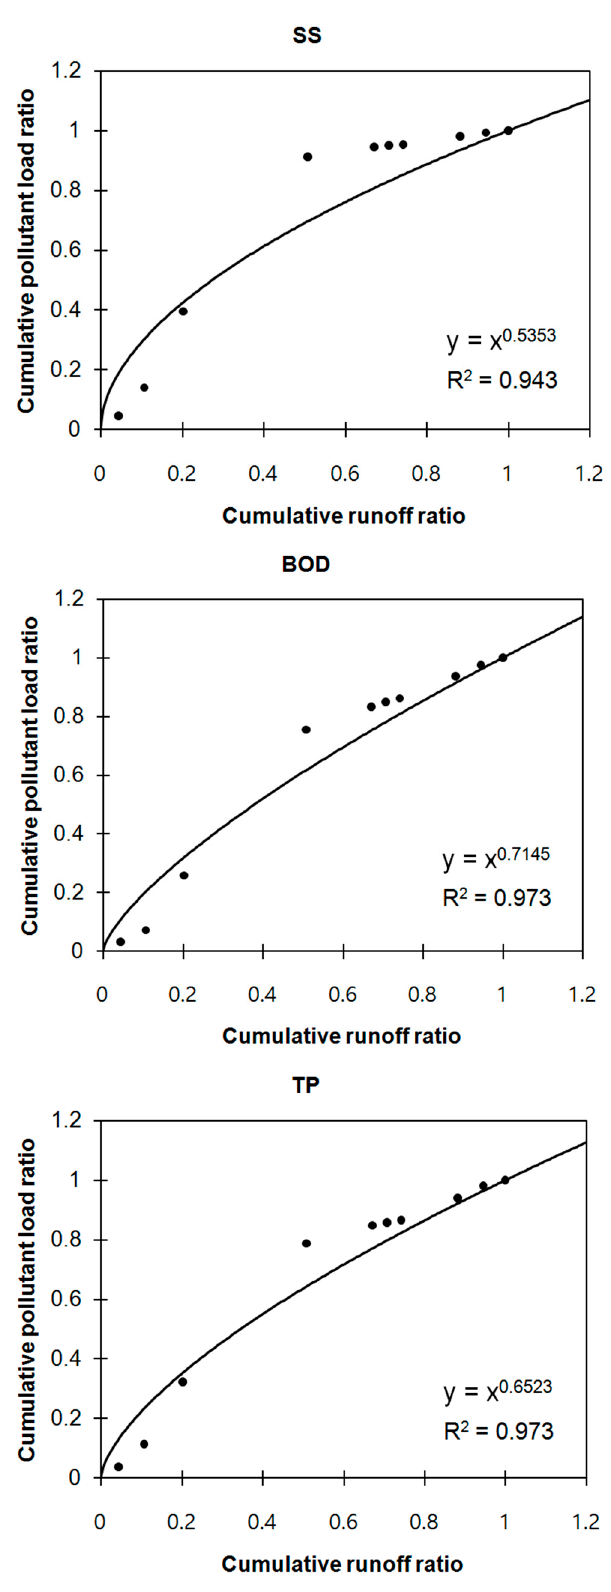
Figure 7. M(V) curve fitting using the power function for Naedongcheon (16–17 July 2016). Figure 7. M ( V ) curve fitting using the power function for Naedongcheon (16–17 July